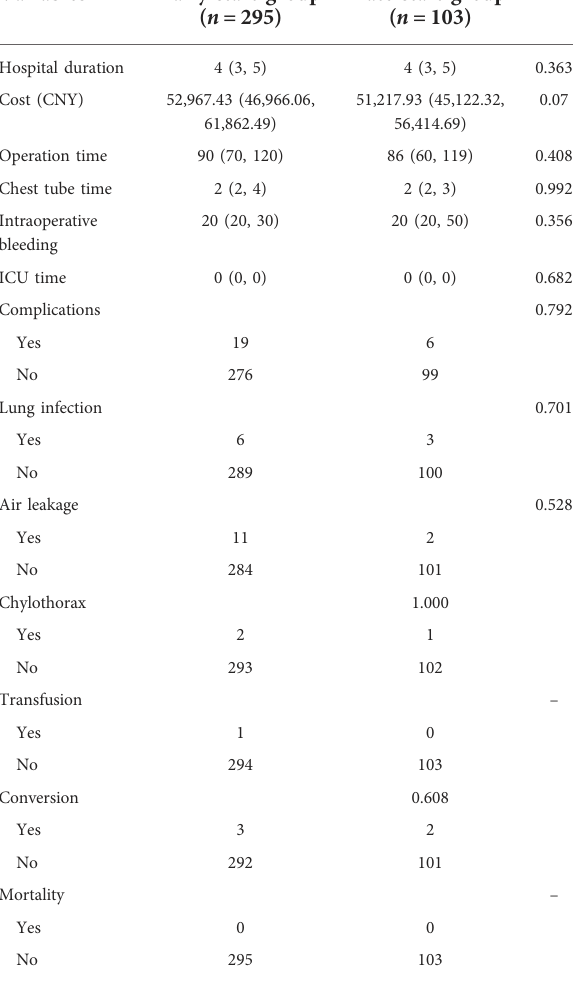
TABLE 2 Outcome comparison between the early-stage and late-start